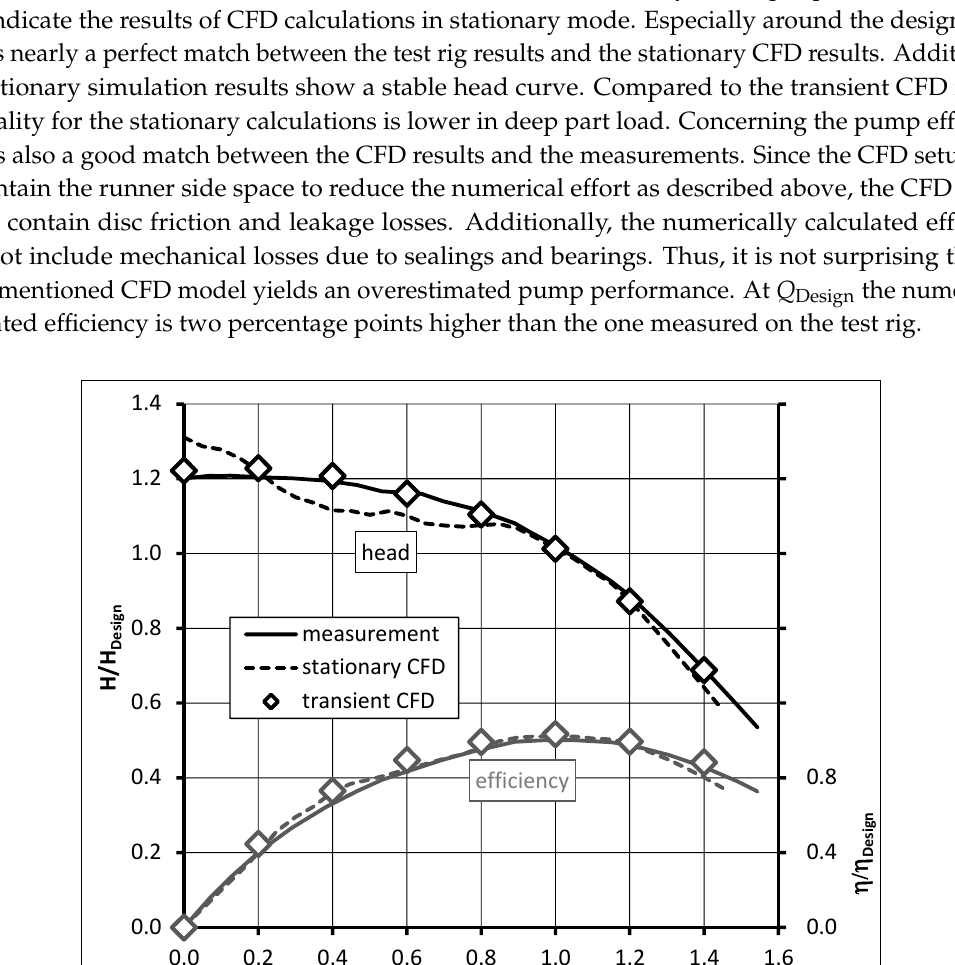
Figure 8. Head curves for variable pitch pump at different positions, CFD (dashed) vs. test rig (solid).